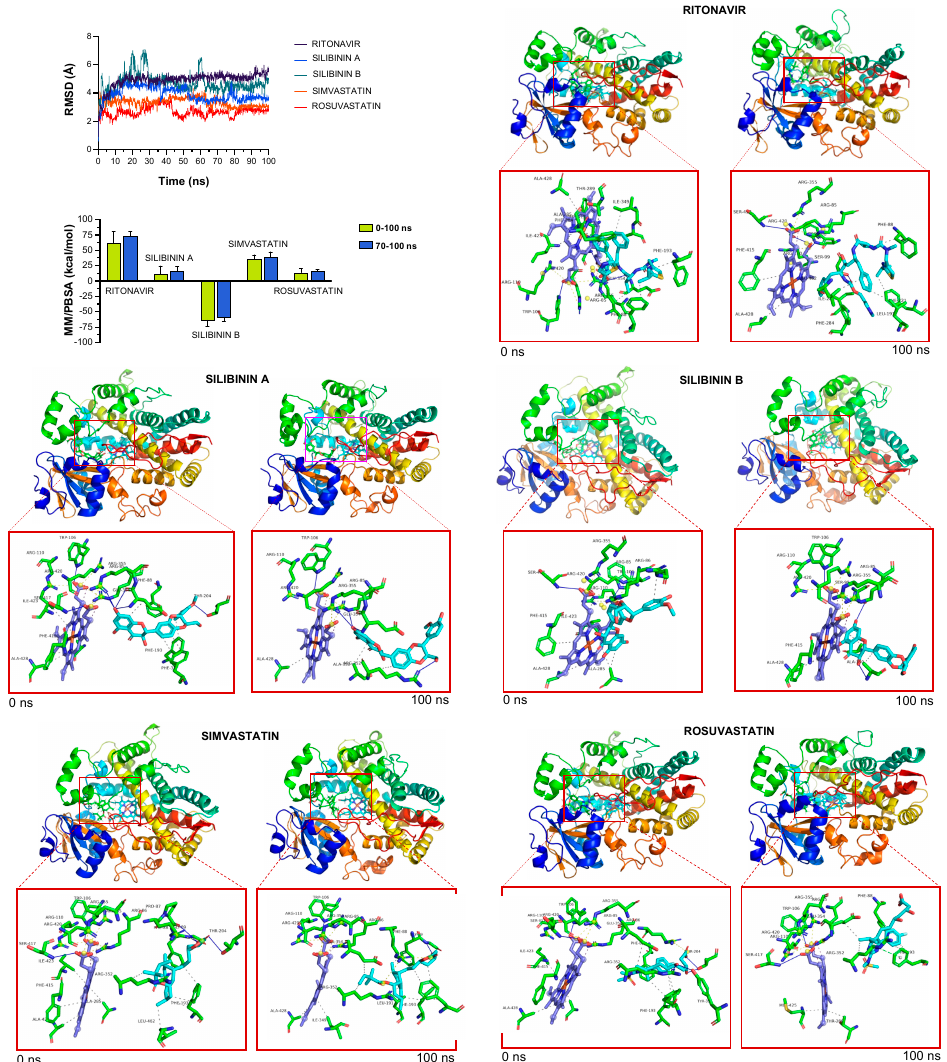
Figure 4. Incorporation models of CYP3A4-targeting drugs: ritonavir and statins vs silibinin. The root mean square deviation (RMSD, Å) of each drug’s heavy atoms over the simulation time, meas- ured after superposing the protein onto its reference structure, and the molecular mechanics Pois- son–Boltzmann surface area (MM/PBSA) binding energy analyses calculated from the entire trajec- tory of the 100 ns (or last 30 ns) MD simulation, are shown. The best poses of ritonavir, silibinin A, silibinin B, simvastatin, and rosuvastatin coupled to the catalytic site of CYP3A4 before (0 ns) and after (100 ns) the molecular dynamics (MD) simulation are shown. The protein is represented as a function of the hydrophobicity of its surface amino acids and the Na + and Cl − ions have been elimi- nated to facilitate visualization. Each inset shows the detailed interactions of the participating amino acids involved and the type of interaction (hydrogen bonds, hydrophilic interactions, salt bridges, Π -stacking, etc.). The inhibitory effects of graded concentrations of simvastatin, rosuvastatin, silibinin, and Eurosil 85 ® /Euromed –a standardized pharmaceutical preparation containing 60% silibinin with an enhanced bioavailability (>80%) that is commonly used in clinical re- search [40,41]—on CYP3A4 activity were finally evaluated using the Vivid ® CYP450 Red screening assay, which employs microsomes prepared from insect cells (baculosomes) ex- pressing a human CYP450 isoenzyme (CYP3A4 in this case) and human cytochrome P450